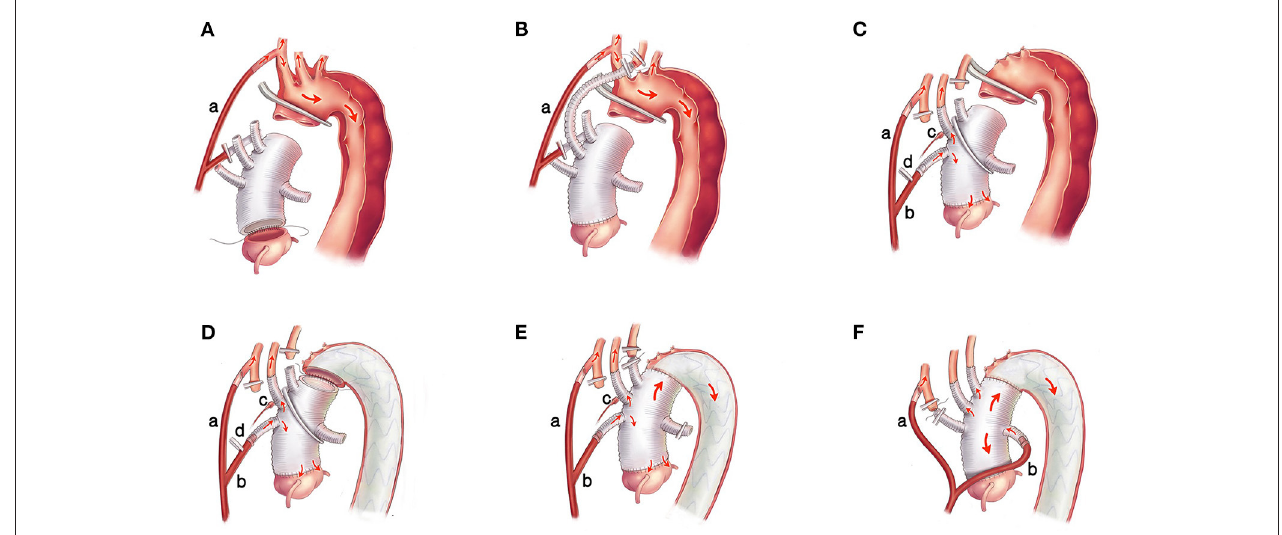
FIGURE 1 | The surgical procedures of the Brain-Heart-first strategy. (A) One end of the Y-shaped arterial perfusion cannula (a) is inserted into the right axillary artery to supply the body. The ascending aorta is replaced using a 4-branched graft, and the aortic root/valve/coronary is reconstructed or replaced if necessary. (B) The LCCA is anastomosed with the 2nd branch of the 4-branched graft, and the IA and LSA supply the cerebral circulation system temporarily. (C) The other end of the Y-shaped arterial perfusion cannula (b) is connected with the 1st branch of the 4-branched graft, and the trunk of the graft is cross-clamped between the 2nd and the 3rd branches after de-airing adequately. Continuous perfusion to the heart and LCCA is achieved. The blood pressure of the LCCA is monitored by an arterial pressure catheter (c) and adjusted by partially clamping the perfusion tube in the 1st branch (d). (D) The stented graft is inserted into the true lumen of the descending aorta and anastomosed with the 4-branched graft. (E) The perfusion in the lower body is resumed, and the LSA is anastomosed with the 3rd branch of the 4-branched graft. (F) The perfusion tube is transferred from the first branch to the 4th branch of the 4-branched graft, and the IA is anastomosed with the 1st branch. LCCA, left common carotid artery; IA, innominate artery; LSA, left subclavian